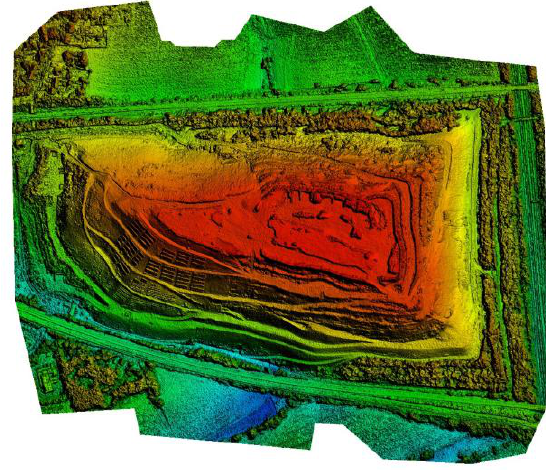
Figure 10 Colorcoded DSM of waste dump